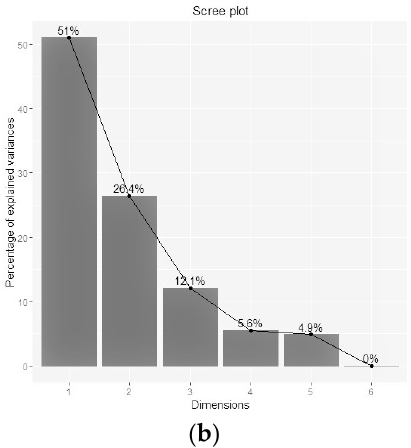
Figure 1. Principal Component Analysis (PCA) ( a ) of subjects clustered according to gender (F = ; M = (cid:78) ) and screen plot ( b ).